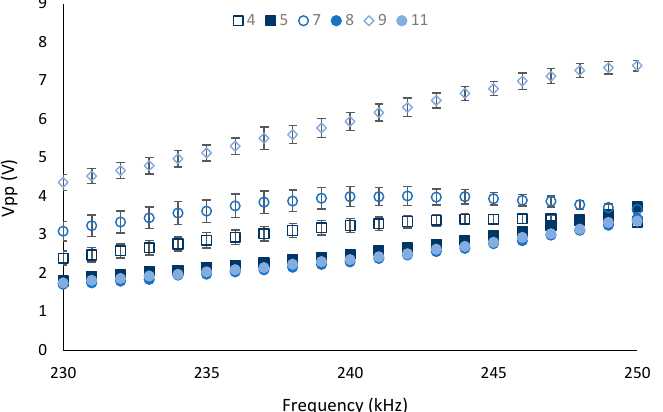
Figure 8. Vpp for the selected frequencies according to the pH value. Data include the repetitions performed for the different temperatures.